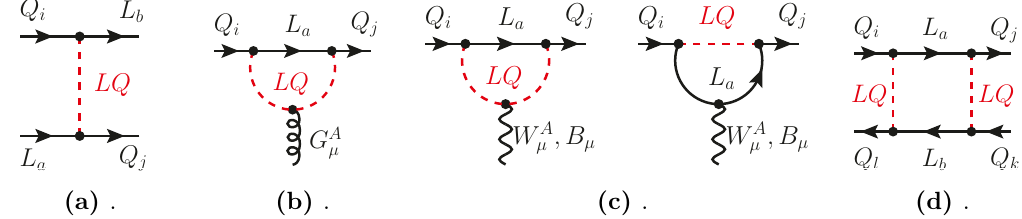
Figure 1. LQ Tree-level exchange (a) gives rise to semi-leptonic operators. One-loop contri- butions to " 0 =" from QCD-penguins (b), EW-penguins (c) and box-type diagrams